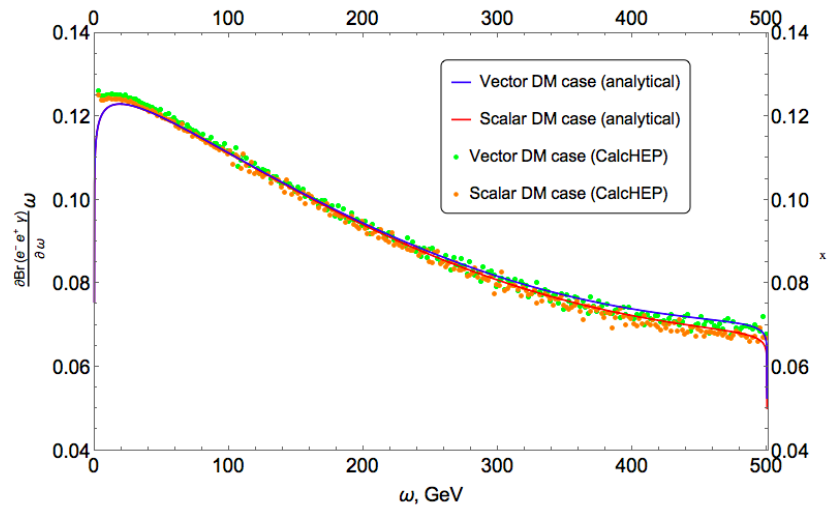
∂ Br ( e − e + γ ) · ω for the case of scalar DM particle ∂ω